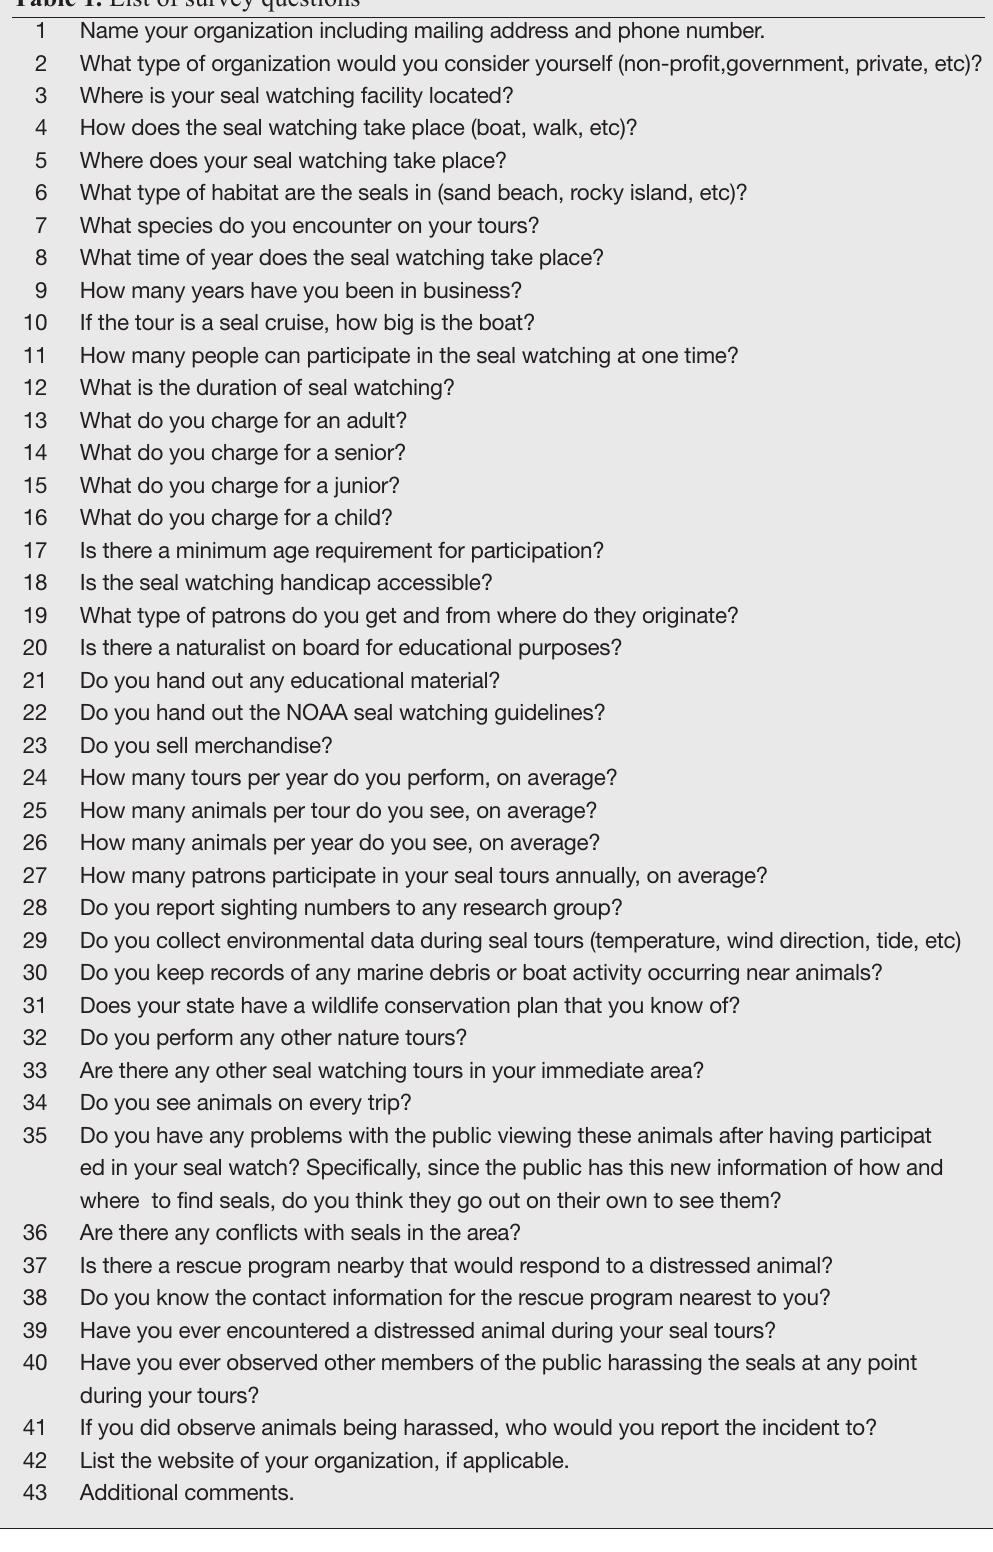
Table 1. List of survey questions